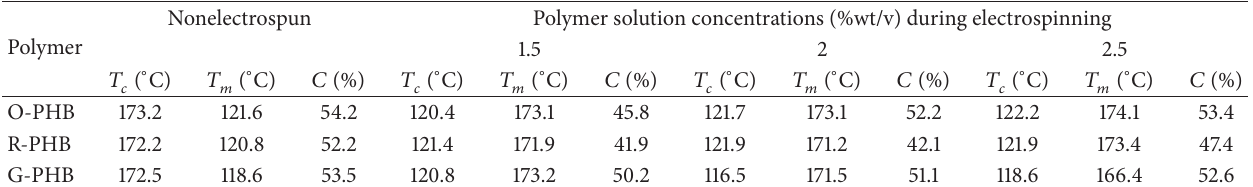
Table 3: Thermal properties of electrospun fibres of PHB from olive oil (O-PHB), rapeseed oil (R-PHB), and glucose (G-PHB) with solution concentrations of 1.5%, 2%, and 2.5%: 𝑇 𝑚 = melting temperature and 𝑇 𝑐 = crystallisation temperature on cooling, and 𝐶 = crystallinity. Polymer